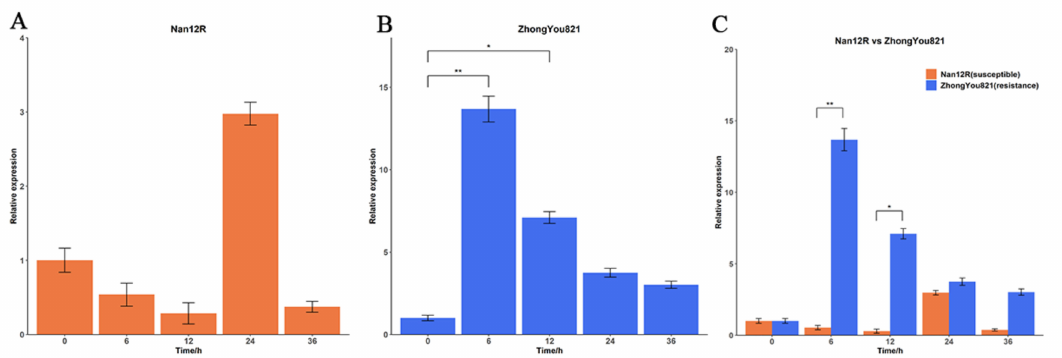
Figure 5. Expression patterns of BnP5CR2 mRNA at 0 h, 6 h, 12 h, 24 h, 36 h treatments under pathogen stress. ( A ). Nan12R; ( B ) ZhongYou821; ( C ) Nan12R vs ZhongYou821. Note: * Significant difference at p < 0.05; ** significant difference at p <